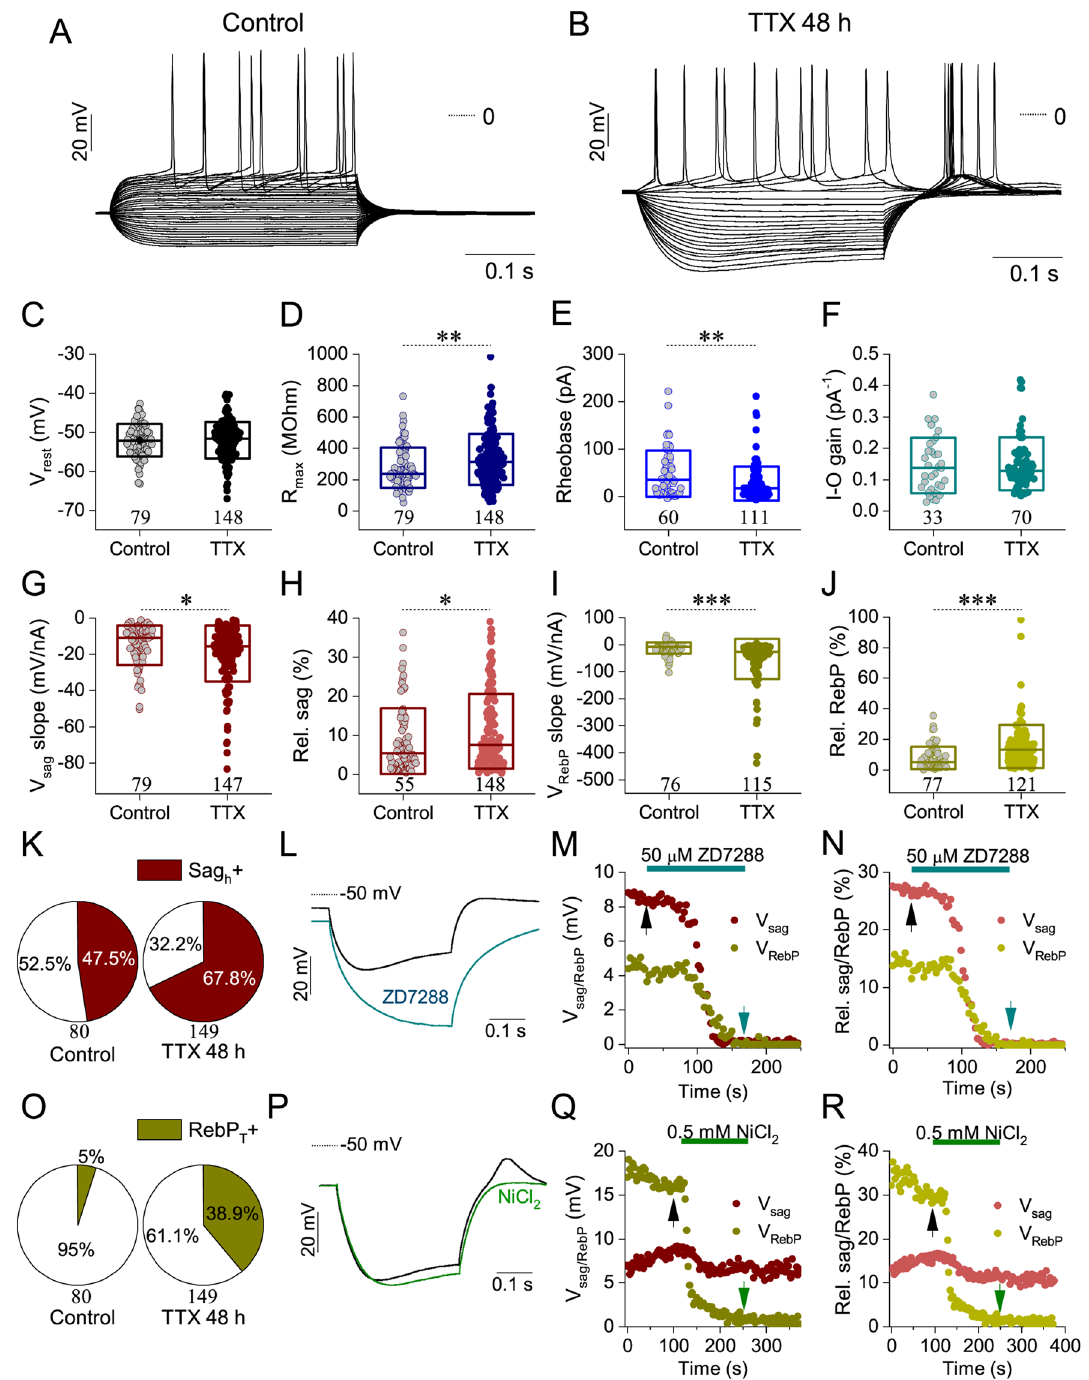
Figure 4. Chronic silencing of electrical activity of hippocampal neurons by 48 h TTX treatment increases their excitability, the degree of their post-inhibitory firing and the magnitude of their voltage sag. Sample voltage traces under current step stimulation from a control and an activity-deprived cell are shown in ( A , B ), respectively. ( C – J ) Scatter plots display physiological parameters calculated from voltage responses of control and TTX-treated neurons, such as average resting membrane potential ( C ), average input resistance ( D ), rheobase ( E ) and I–O relationship ( F ). The initial slope of the voltage sag vs. current and RebP versus current relationship ( G , I , respectively) and the relative voltage sag ( H ) and the relative RebP ( J ) are also presented. The box plots next to the data points indicate median and 25-75% range of data. Pie charts in ( K , O ) illustrate the percentage of cells that are visually classified as exhibiting voltage sag ( K ) or T-current mediated PIR ( O ), respectively. ( L ) Voltage responses of a TTX-treated neuron exhibiting clear voltage sag in normal ACSF (black trace) and monoexponential voltage deflection (teal) after application of HCN channel blocker ZD7288. ( M , N ) show the absolute ( M ) and relative ( N ) voltage sag and rebound potential as the function of time while stimulating the neuron in 3 s intervals using a fixed − 150 pA current step. Both parameters drop quickly after the introduction of ZD7288 at t = 70 s. ( P ) Bath application of NiCl 2 (green) removes the post-inhibitory T-current mediated rebound depolarization while voltage sag is only slightly influenced by NiCl 2 . ( Q , R ) display the time courses of the voltage sag and rebound potential parameters during the NiCl 2 experiment, respectively. Data are derived from 13–13 independent cultures. Number of recorded cells is indicated on the graphs (*p < 0.05; **p < 0.01; ***p < 0.001; ( C ) Independent samples t-test, ( D – J ) Mann–Whitney U